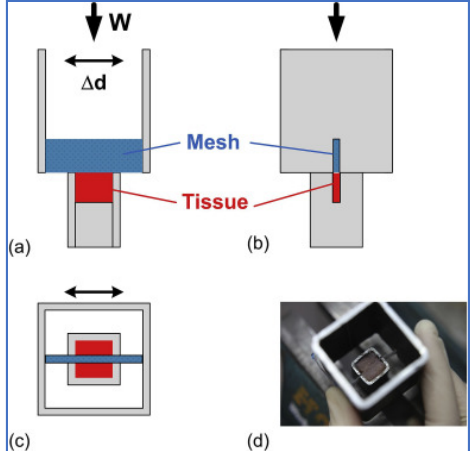
Figure 2. Original equipment developed for erosion testing by Taylor and Barton, 2020 [16]. ( a ) View from the front: a piece of mesh is secured in a metal holder, which slides back and forth a distance Δ d while applying a force W. A sample of tissue is placed in a second holder and kept stationary. ( b ) View from the side: as the piece of the mesh erodes the tissue, it descends in two slots on the side of the holder, creating a vertical cut in the tissue. ( c ) View from the top. ( d ) A photograph looking down from the top after testing.